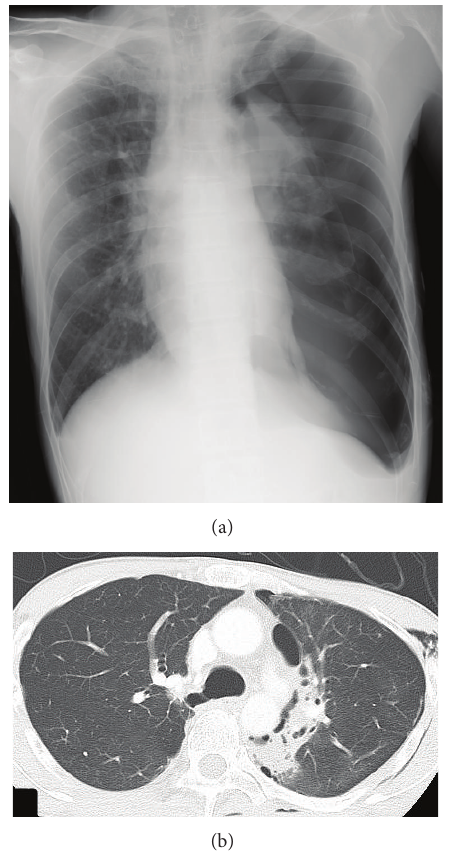
Figure 1: Chest X-ray performed at initial presentation and chest computed tomography on the 11th hospital day. (a) On admission, chest X-ray showed a left-sided pneumothorax. (b) On the 11th hospital day, chest computed tomography showed intrapulmonary infiltration on the mediastinal side of the left upper lobe, and no emphysematous changes were